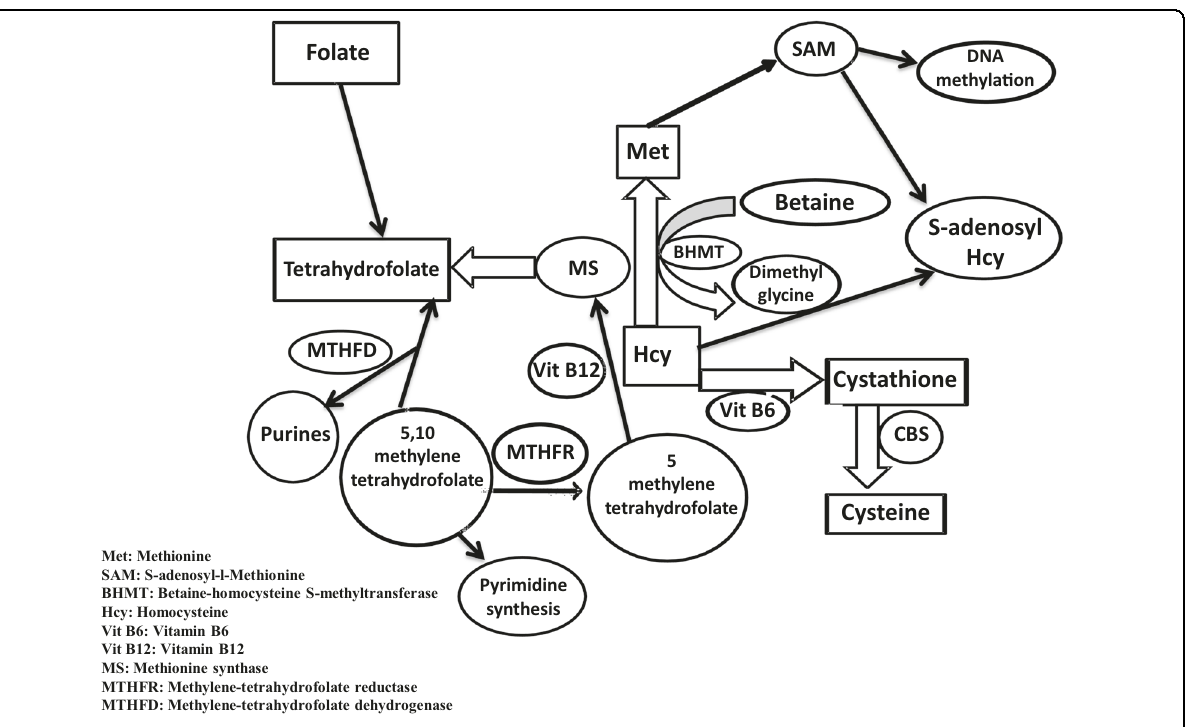
Fig. 2 Folate metabolism is linked to the homocysteine metabolic